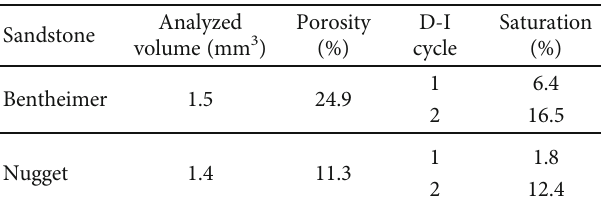
residual saturation. 2